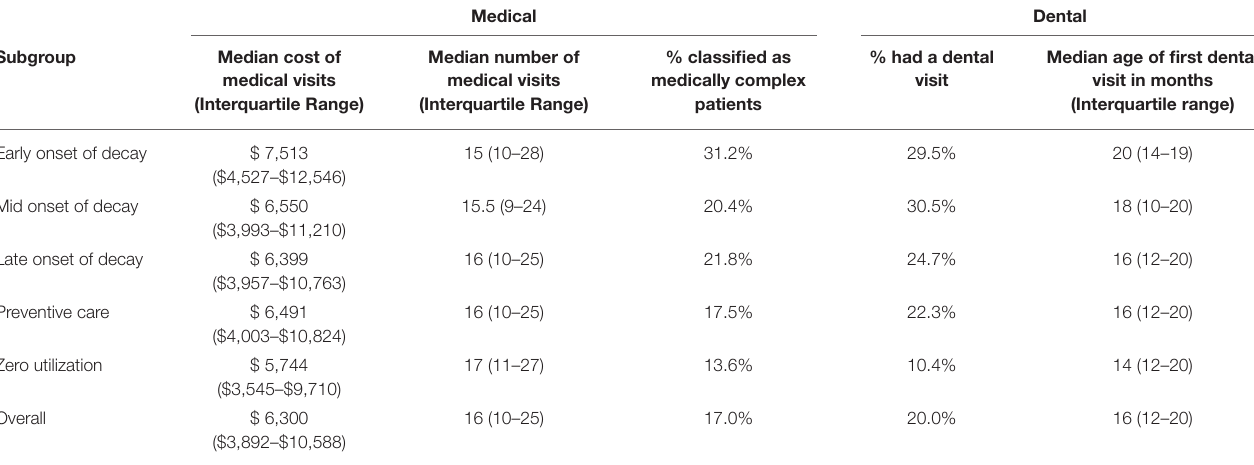
TABLE 4 | Medical and dental care characteristics of the five subgroups prior to 24 months old (Total N = 24,223). Medical